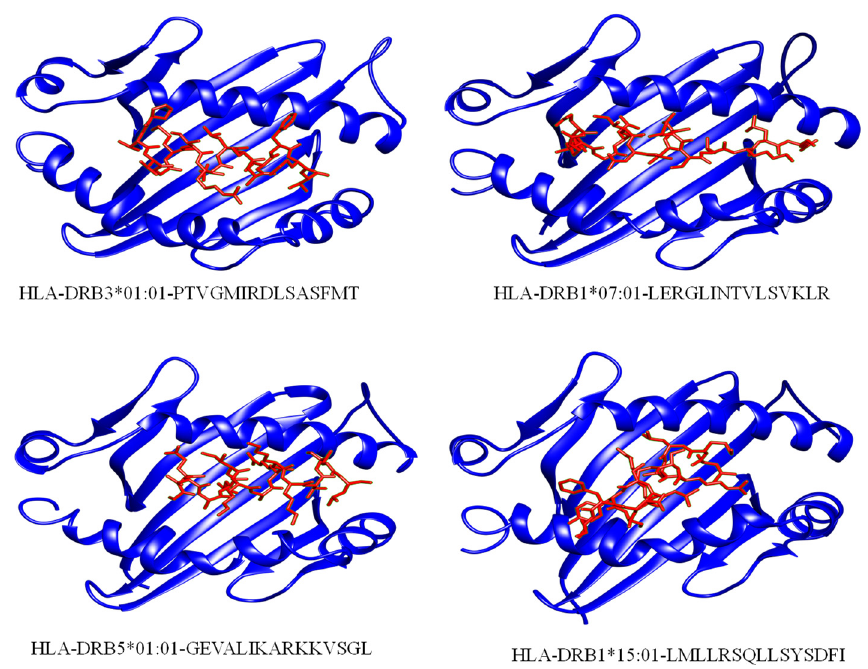
Figure 4. Selected HTL epitopes’ docking complexes with respective HLAs. The epitope is shown in a red color whereas the human leukocyte antigens are presented in a dark blue color.